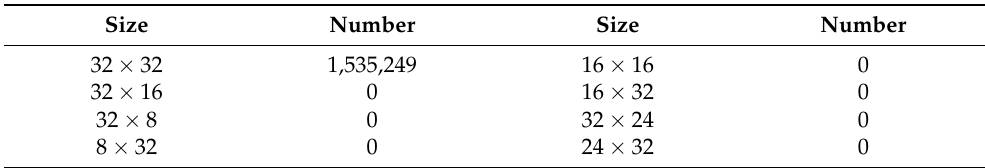
Table 4. Example of block partitioning information of 32 × 32 inter coded CU in HEVC encoder’s de-